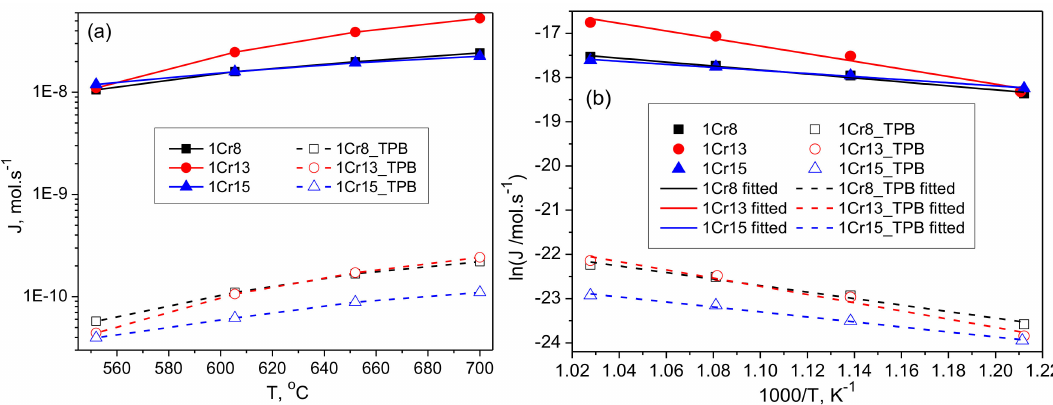
Figure 7. ( a ) Deuterium permeation flux of Cr steel samples before and after coating with aluminide tritium permeation barriers (TPBs) and ( b ) the corresponding Arrhenius